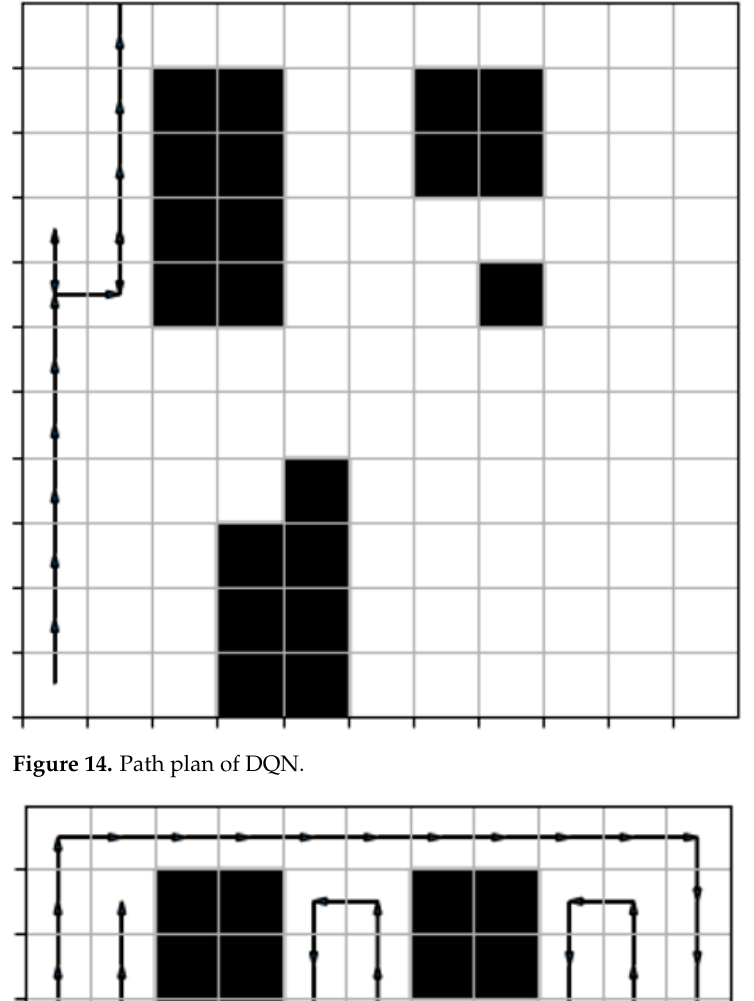
Figure 14. Path plan of DQN.